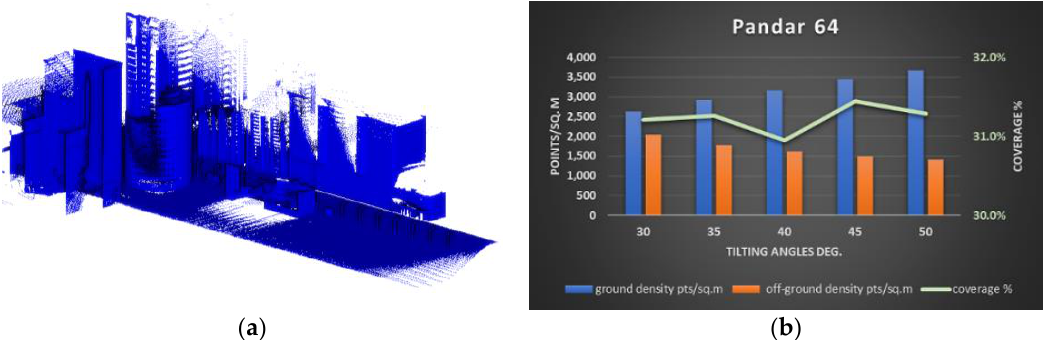
Figure 13. Pandar64 point cloud density on the ground and off ground features and their achieved